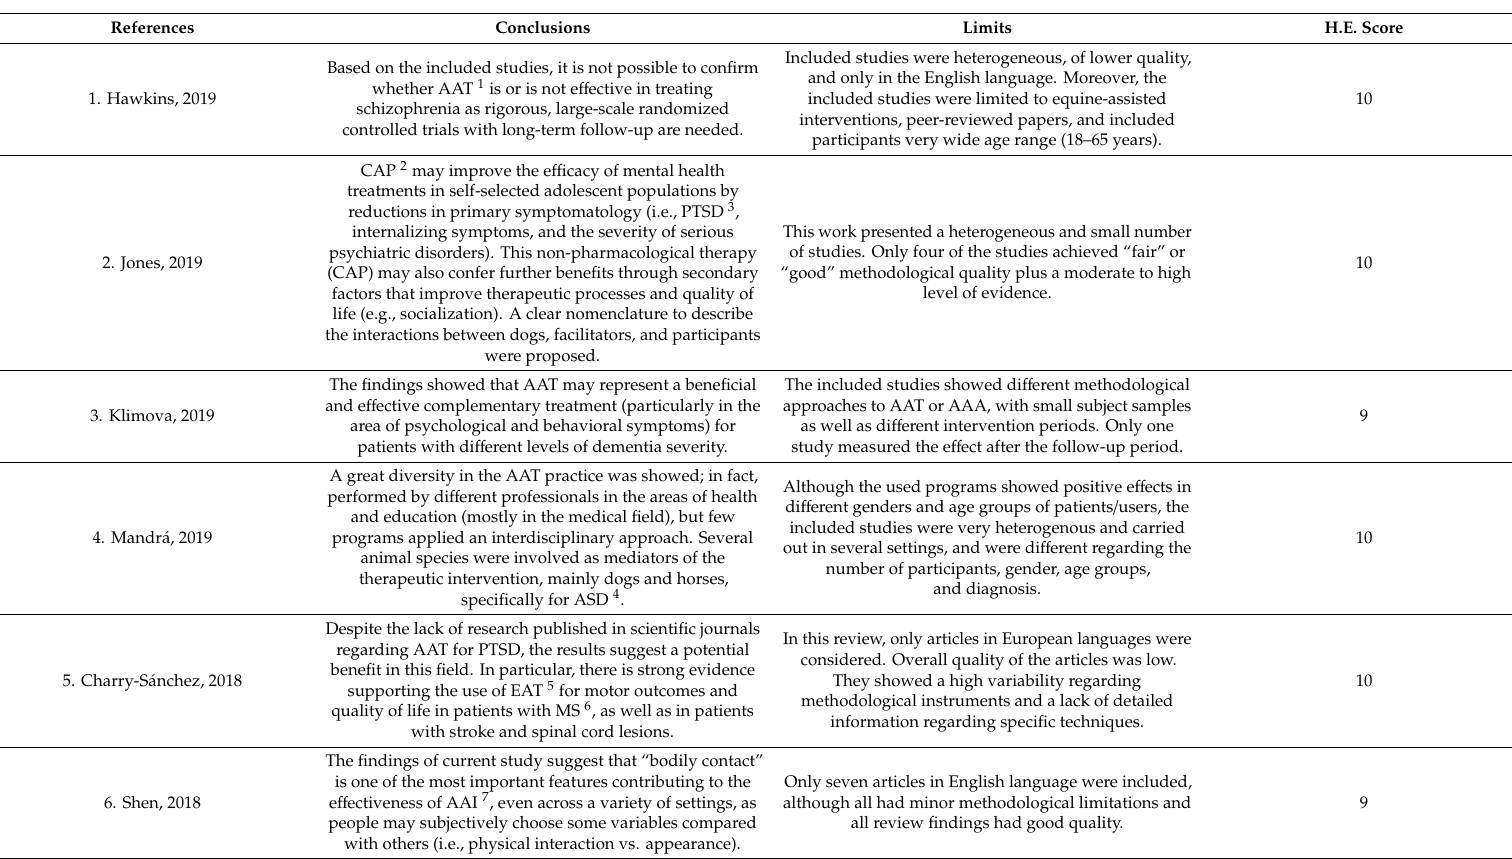
Table 5. General description and evaluation of included reviews’